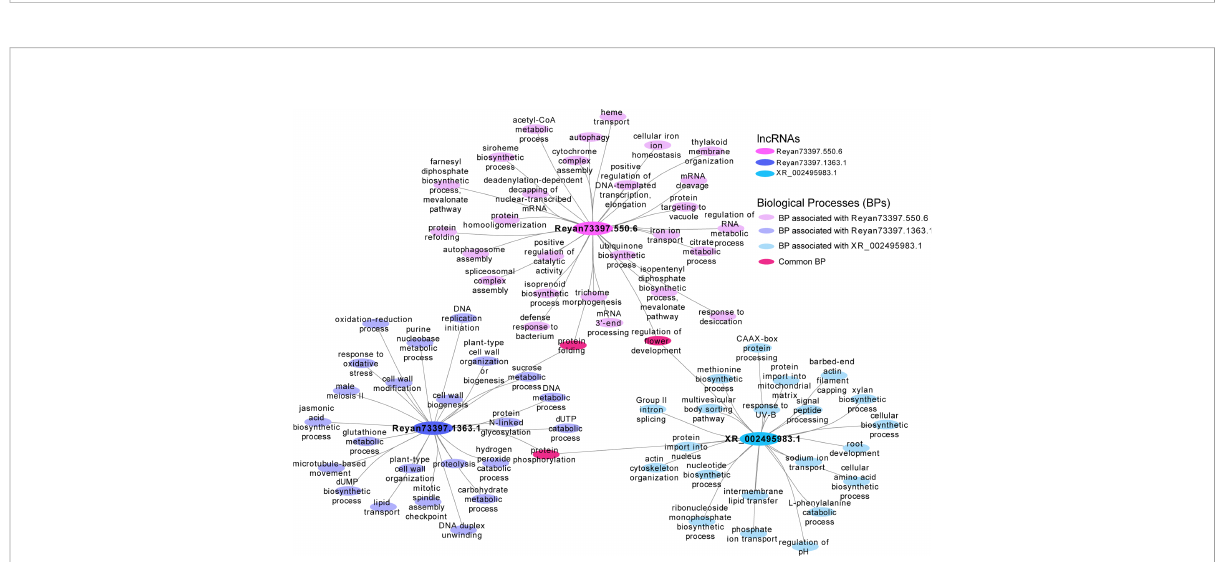
FIGURE 6 Functional network of three latex-speci fi c lncRNAs. The biological processes in association with the latex-speci fi c lncRNAs, Reyan73397.1363.1, Reyan73397.550.6, and XR_002495983.1. The big ellipse represents the lncRNAs, while the small ellipse indicates the biological